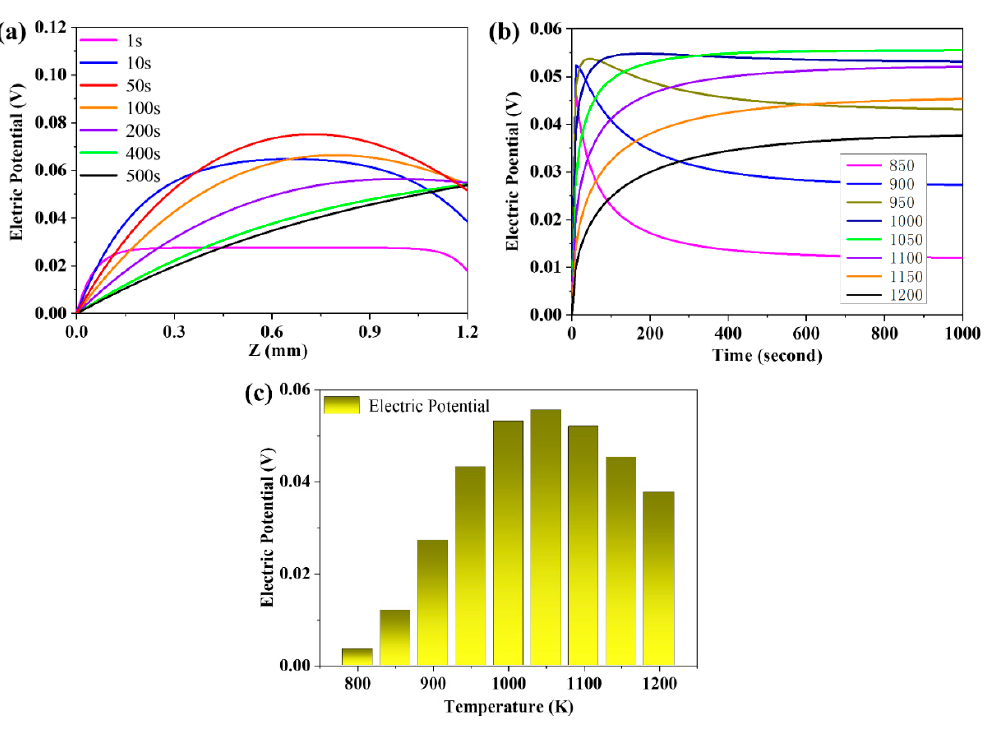
Figure 5. ( a ) The distribution of electric potential in the membrane at 1000 K; ( b ) the evolution curves of electric potential on Side B at di ff erent temperatures; and ( c ) the electric potential on Side B at the of electric potential on Side B at different temperatures; and ( c ) the electric potential on Side B at the time of 1000 time of 1000 s.